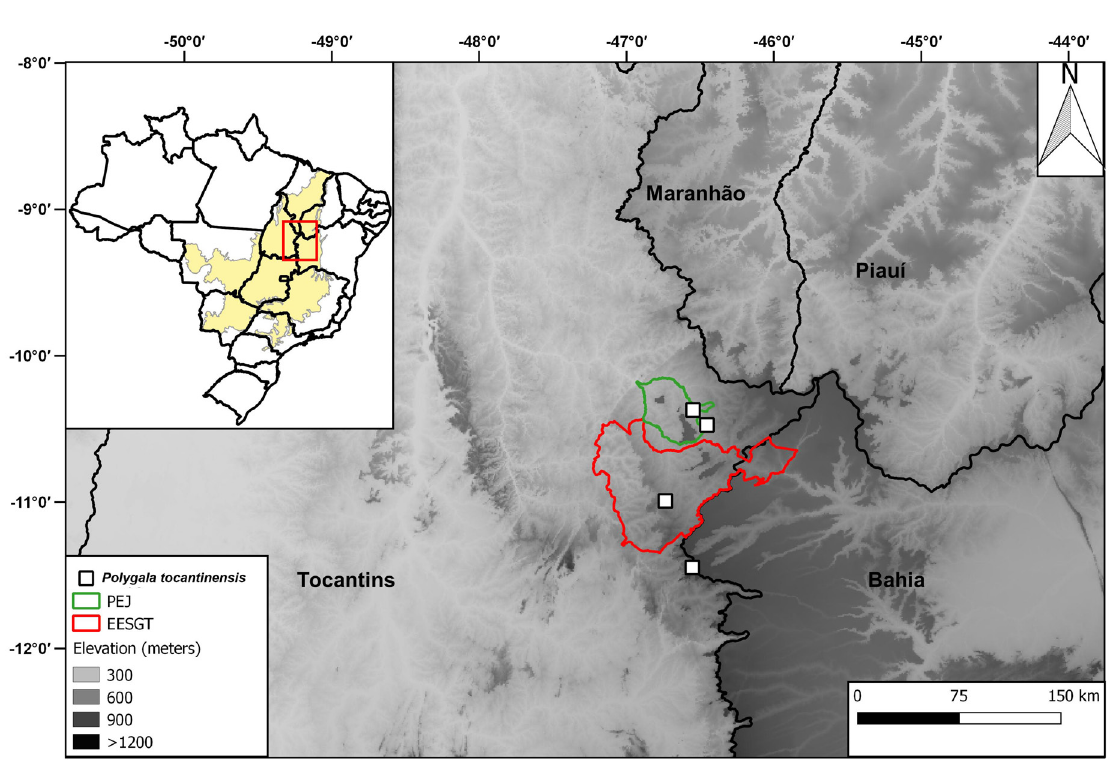
Fig. 6. Geographical distribution of Polygala tocantinensis J.F.B.Pastore & Antar sp. nov. (squares). PEJ = Parque Estadual do Jalapão, EESGT = Estação Ecológica Serra Geral do Tocantins. The cream- colored portion of the insert map shows the extent of the Cerrado domain in